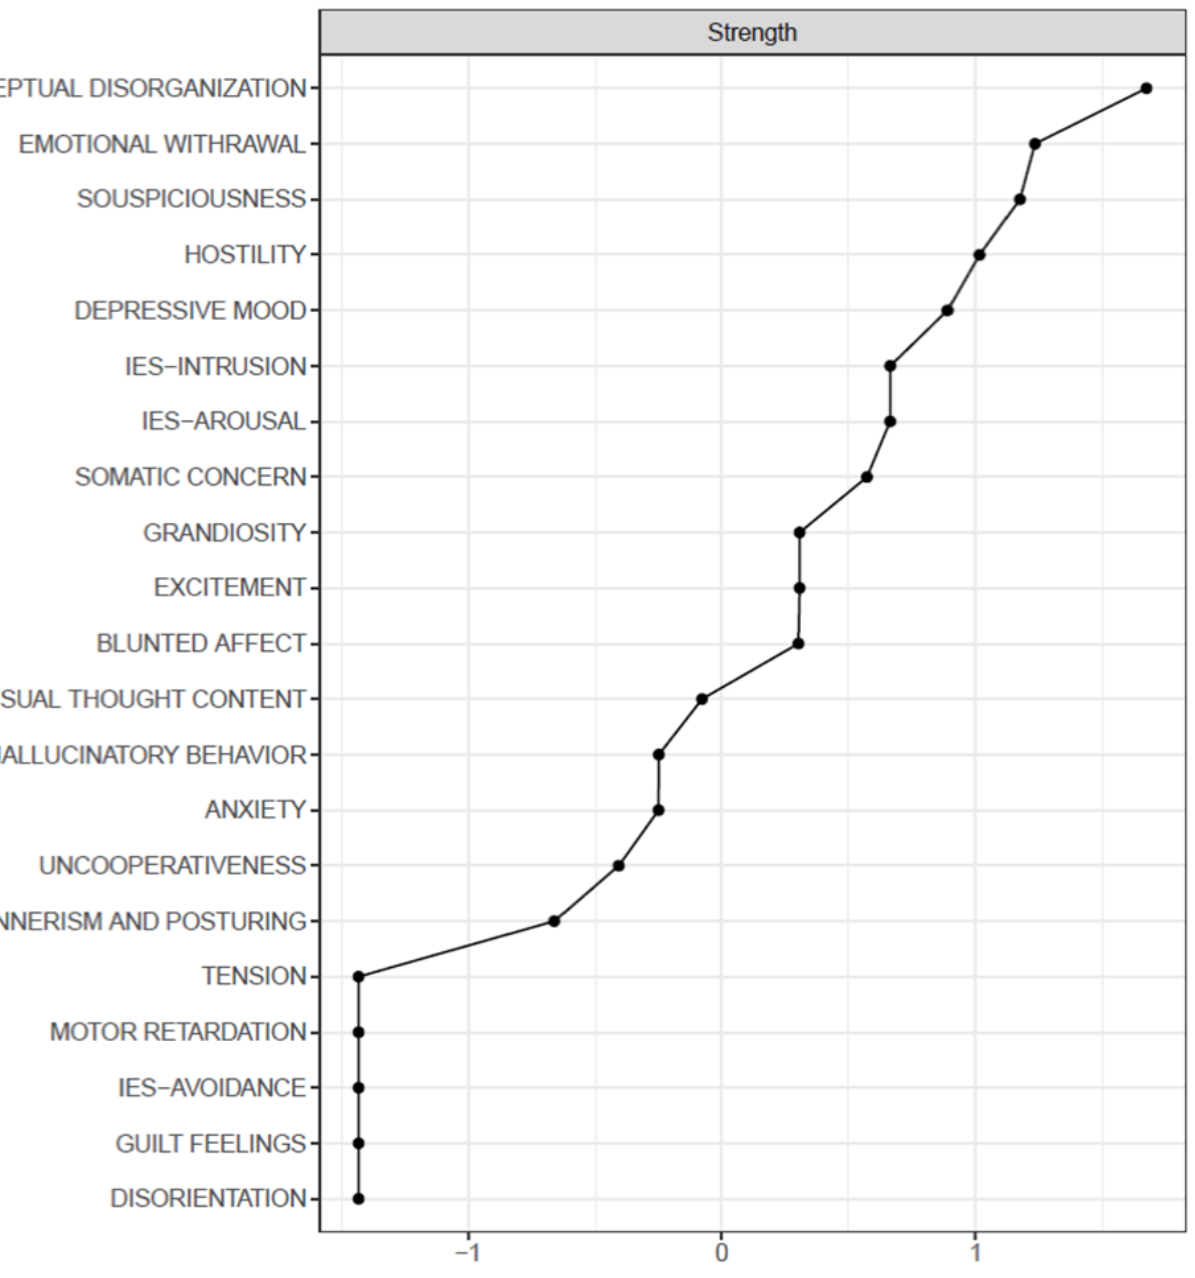
Figure 4. Centrality plot (strength) of the November sample.